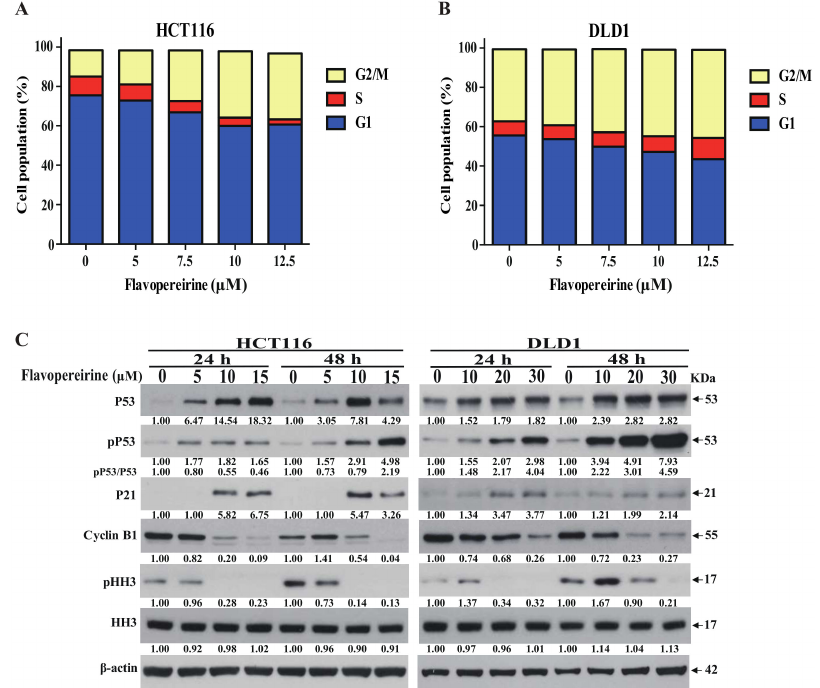
Figure 3. Flavopereirine induced G2 / M-phase cell cycle arrest. ( A ) The cell cycle distributions of HCT116 and DLD1 were assayed and quantified after flavopereirine treatment for 24 h. Values were expressed as cell population [%]. ( B ) Flavopereirine upregulated P53 and P21 expression and phosphorylation, downregulated cyclin B1, and diminished the phosphorylation of histone H3 after 24 h and 48 h treatment. Numbers under the plots indicate the fold change of protein level relative to their untreated control. Similar results were obtained for at least three independent